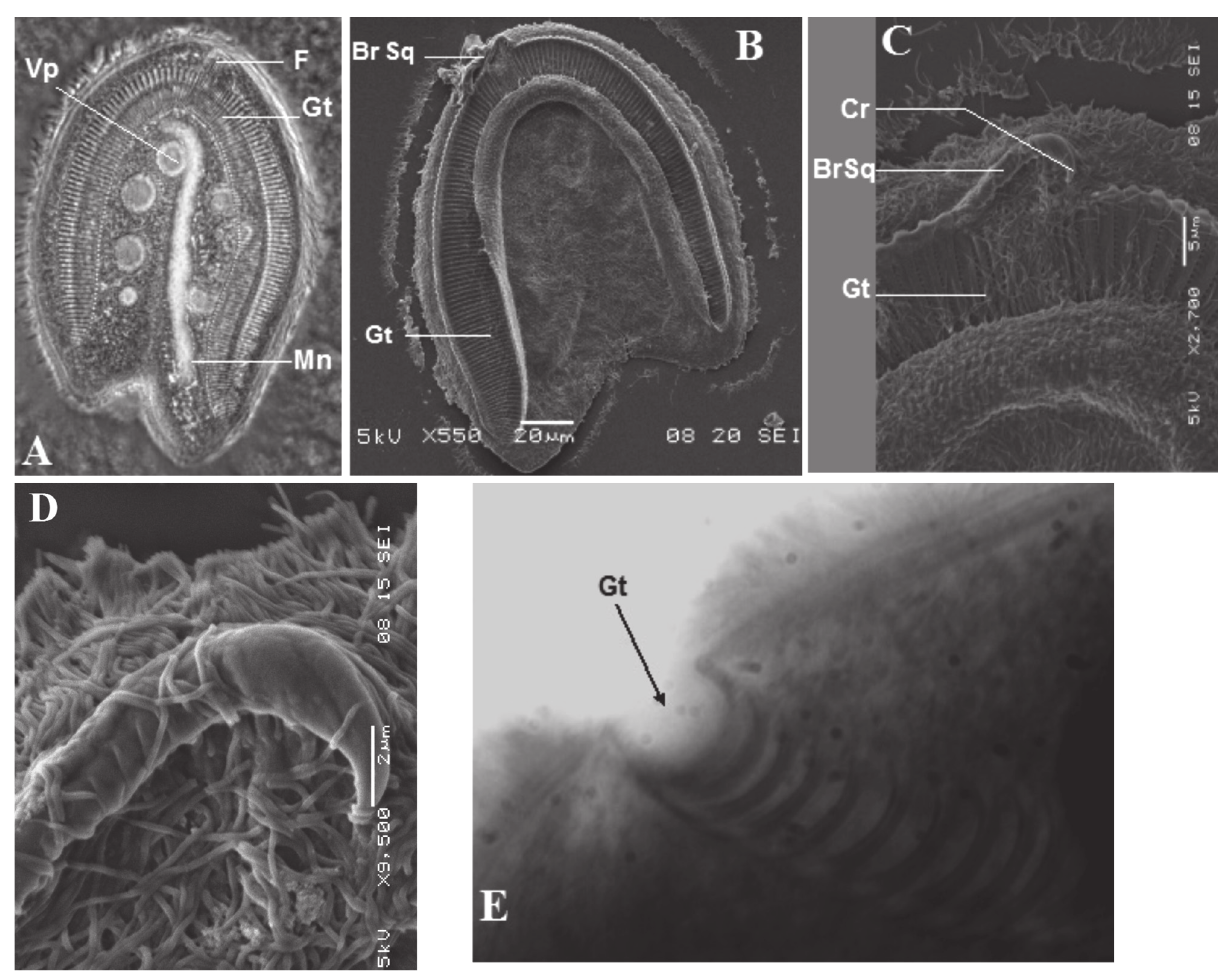
Figure 6. – Photographies de Dicoelophrya almae de Puytorac et Dragesco,